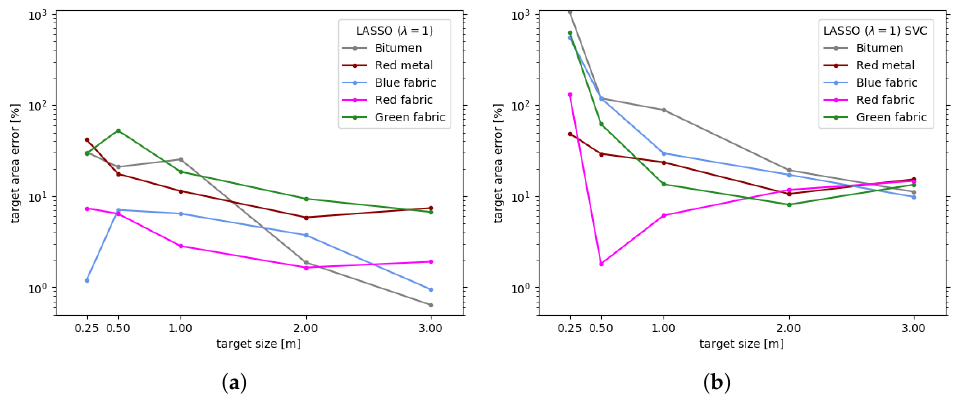
Figure 19. Target area error for different target materials and sizes for LASSO ( λ = 1). The error measure shown here is the unsigned relative error case of using the spectral library collected from the HySpex image ( a ) and from the mean SVC acquisitions ( b